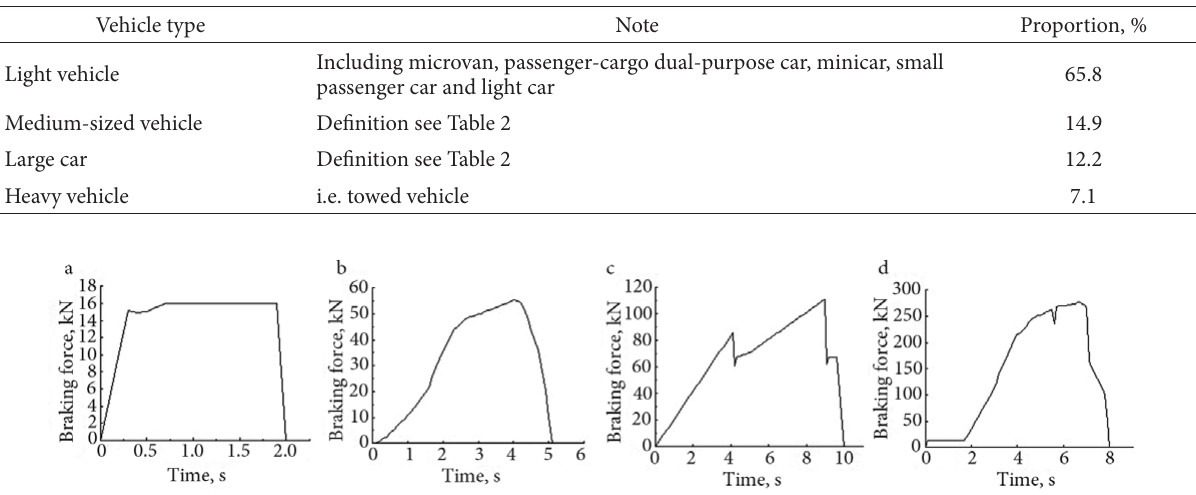
Fig. 2. Vehicle braking force model: a –light vehicle; b – medium-sized vehicle; c – large car; d – heavy